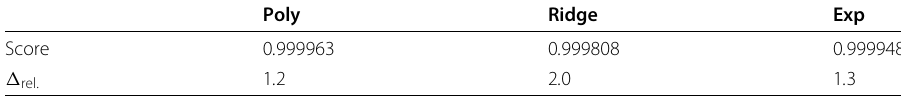
Table 7 Comparison of quality measures for plate Poly Ridge Exp Score 0 . 999963 0 . 999808 0 . 999948